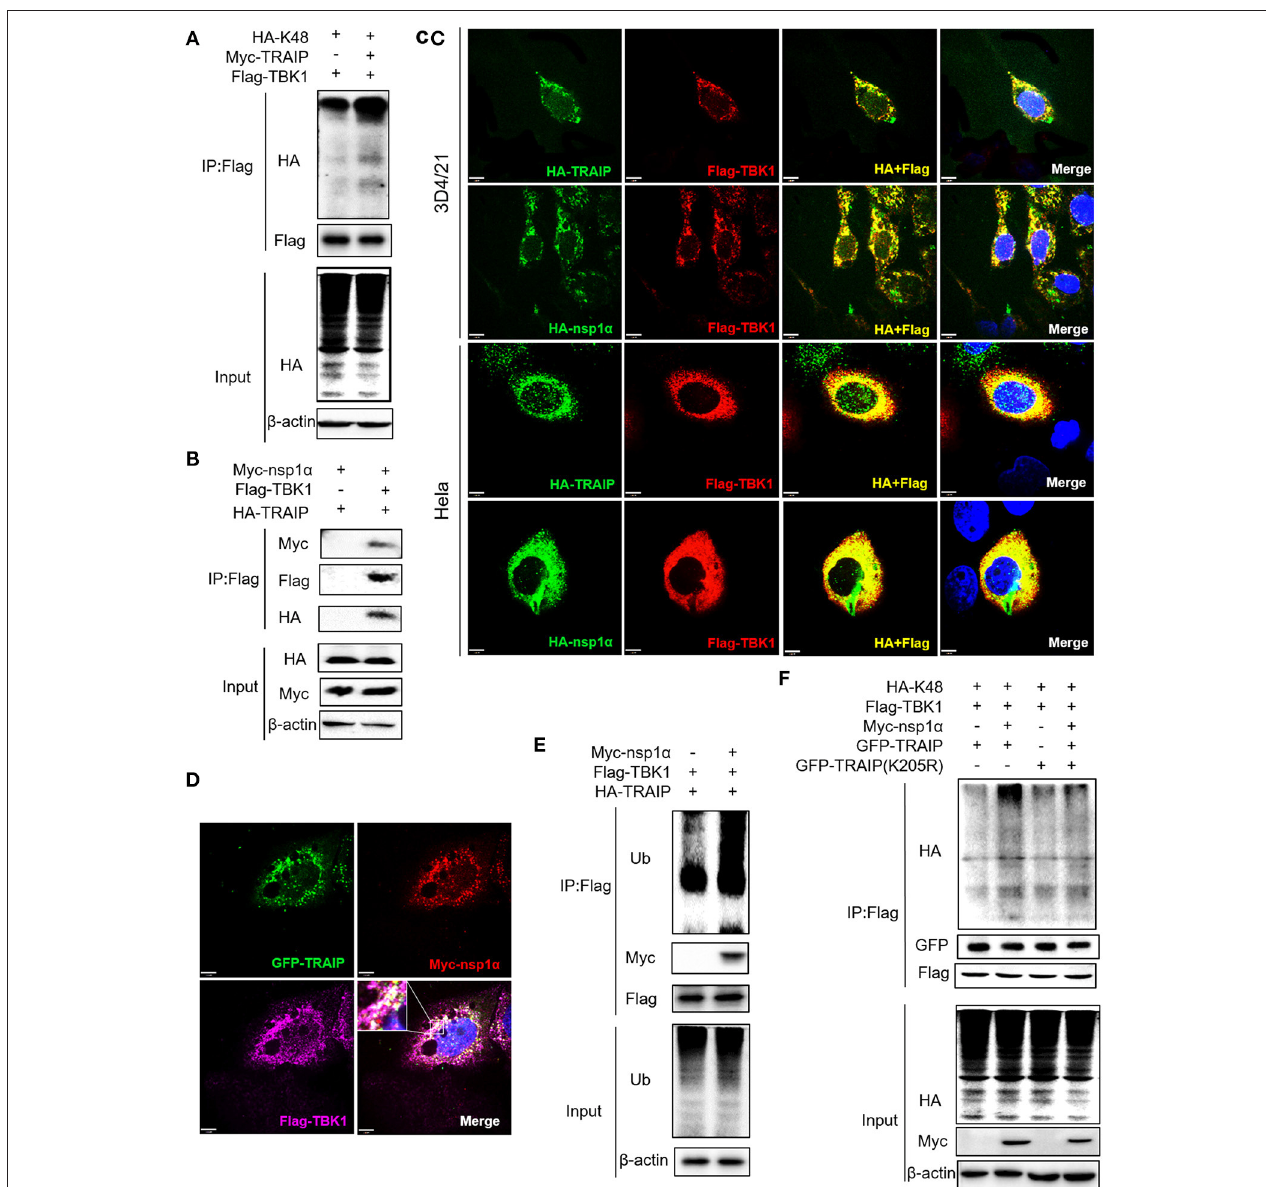
FIGURE 9 | Nsp1 α forms trimer complex with TRAIP and TBK1. (A,F) Detection of Lys48 (K48)-linked polyubiquitination of TBK1. HEK 293T cells were transfected with Flag-TBK1, Myc-TRAIP, HA-K48, or Myc-empty vector (A) or HA-K48, GFP-TRAIP or GFP-TRAIP (K205R), Flag-TBK1, Myc-nsp1 α , or Myc-empty vector (F) . At 24h post-transfection, FLAG-immunoprecipitates were probed with HA antibodies to detect to Lys48 (K48)-linked polyubiquitination of TBK1. (B) HEK293T cells were co-transfected with Myc-nsp1 α , HA-TRAIP, Flag-TBK1, or Flag-empty vector. FLAG immunoprecipitation (IP) was used to detect the interaction of TBK1, nsp1 α , and TRAIP. (C) Immunofluorescence was used to detect the interaction between TBK1, nsp1 α , and TRAIP in 3D4/21 and HeLa cells. (D) Co-transfection of GFP-TRAIP with Myc-nsp1 α and Flag-TBK1 into HeLa cells. The cells were fixed and double-stained with a mouse anti-Myc antibody and a rabbit anti-Flag antibody and followed by PE-conjugated anti-mouse IgG (red) and IF647 goat anti-rabbit IgG. Nuclei were stained with DAPI (blue). Cells were observed under a laser confocal imaging analysis system, scale bar: 7 µ m. (E) HEK 293T cells were transfected with Flag-TBK1, HA-TRAIP, or Myc-empty vector. At 24h post-transfection, FLAG-immunoprecipitates were probed with Ub antibodies to detect polyubiquitination of